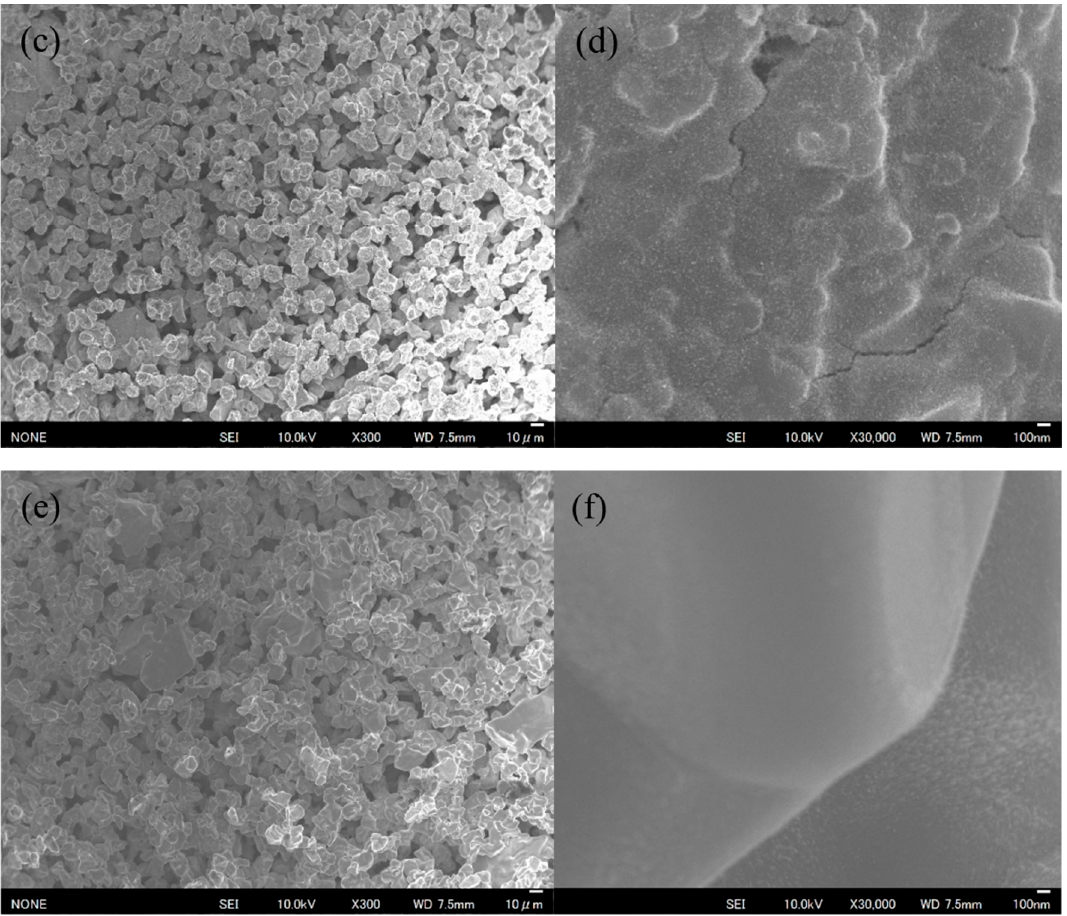
Figure 1. SEM images of the IrO 2 catalyst electrodes coated on porous Ti power sheets: ( a , b ) sample 1, ( c , d ) sample 2, and ( e , f ) sample 3. Table 1. Electrical properties of the IrO 2 catalyst electrodes coated on porous Ti power sheets.